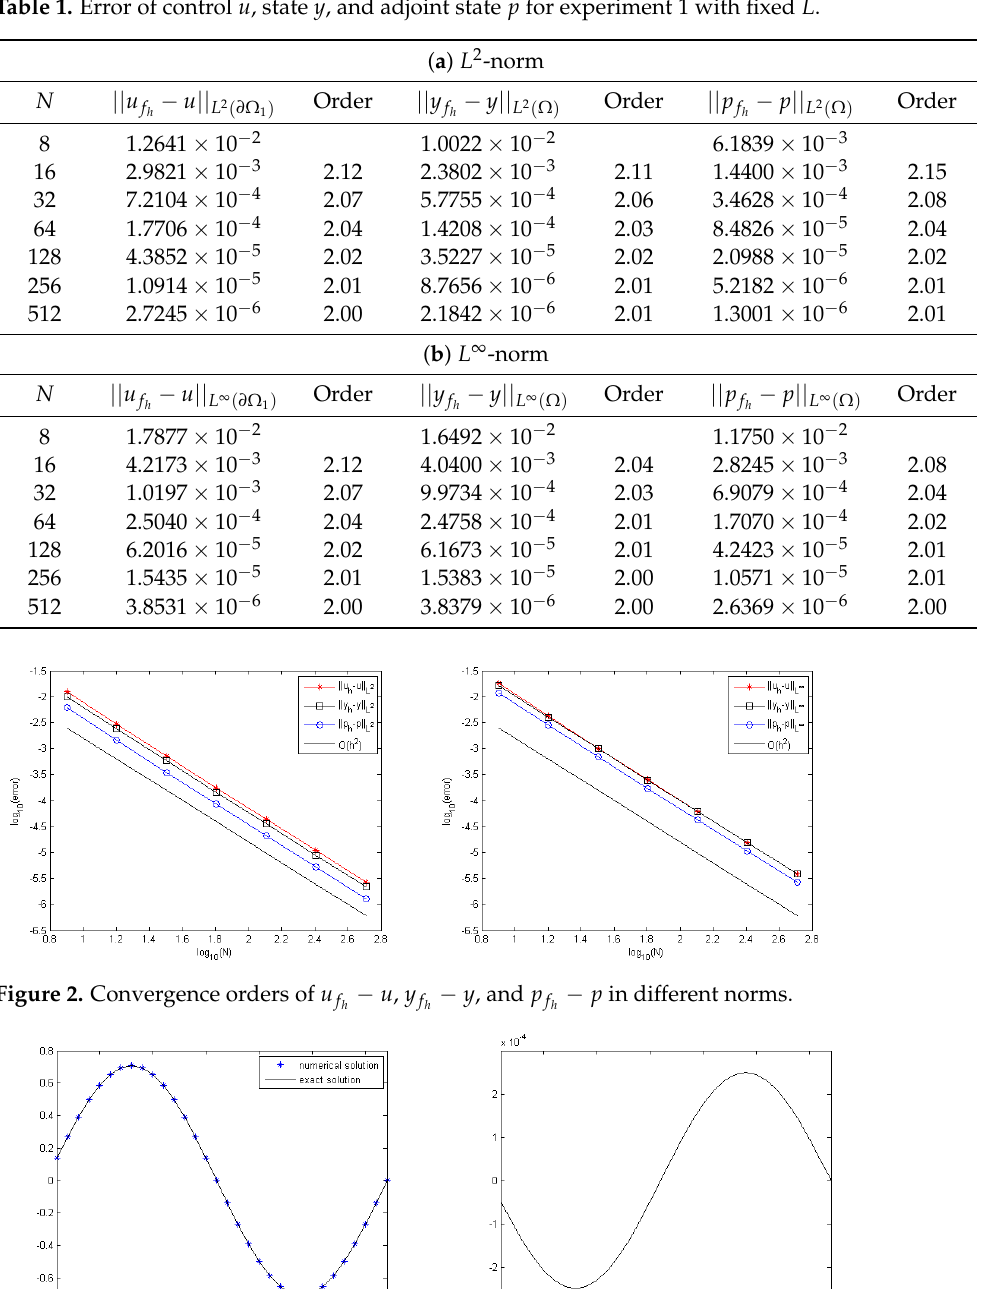
Table 1. Error of control u , state y , and adjoint state p for experiment 1 with fixed L .